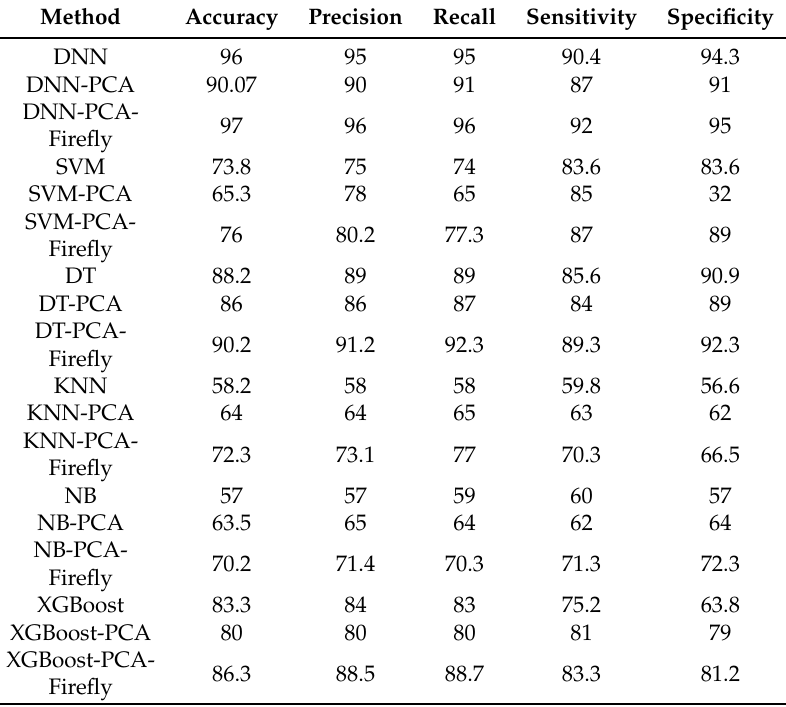
Table 2. Summary of the Experimental